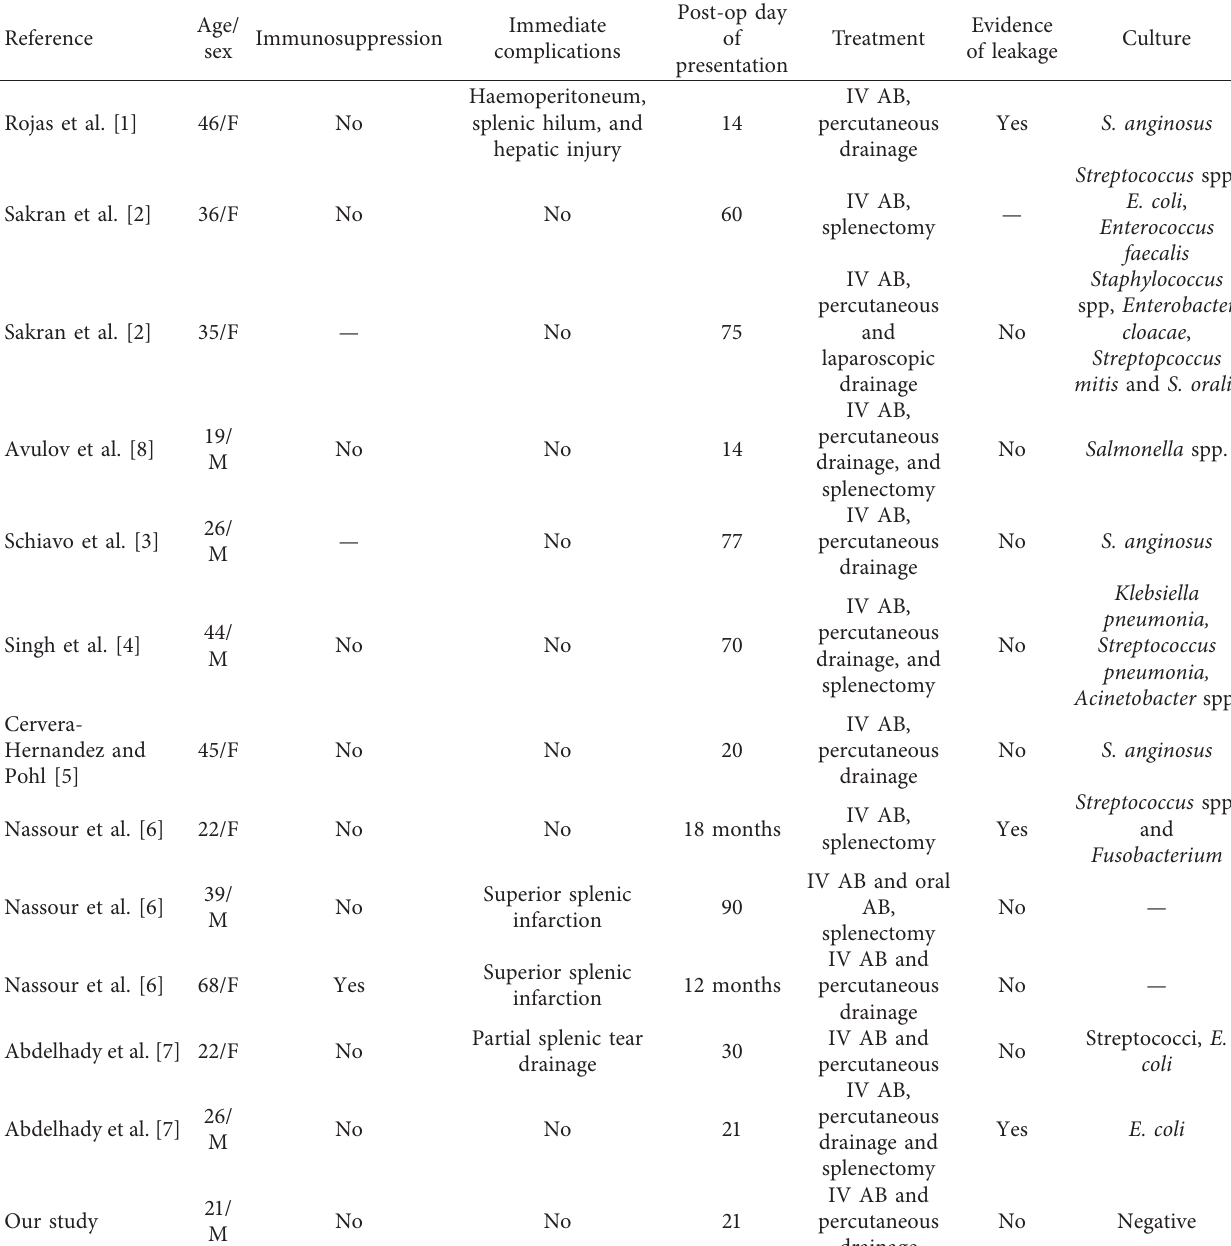
Table 1: Characteristics of the different